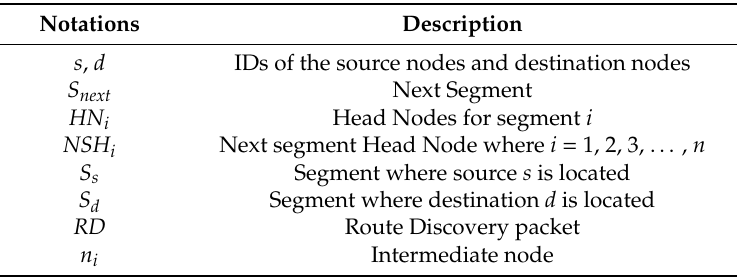
Table 2. Notations with